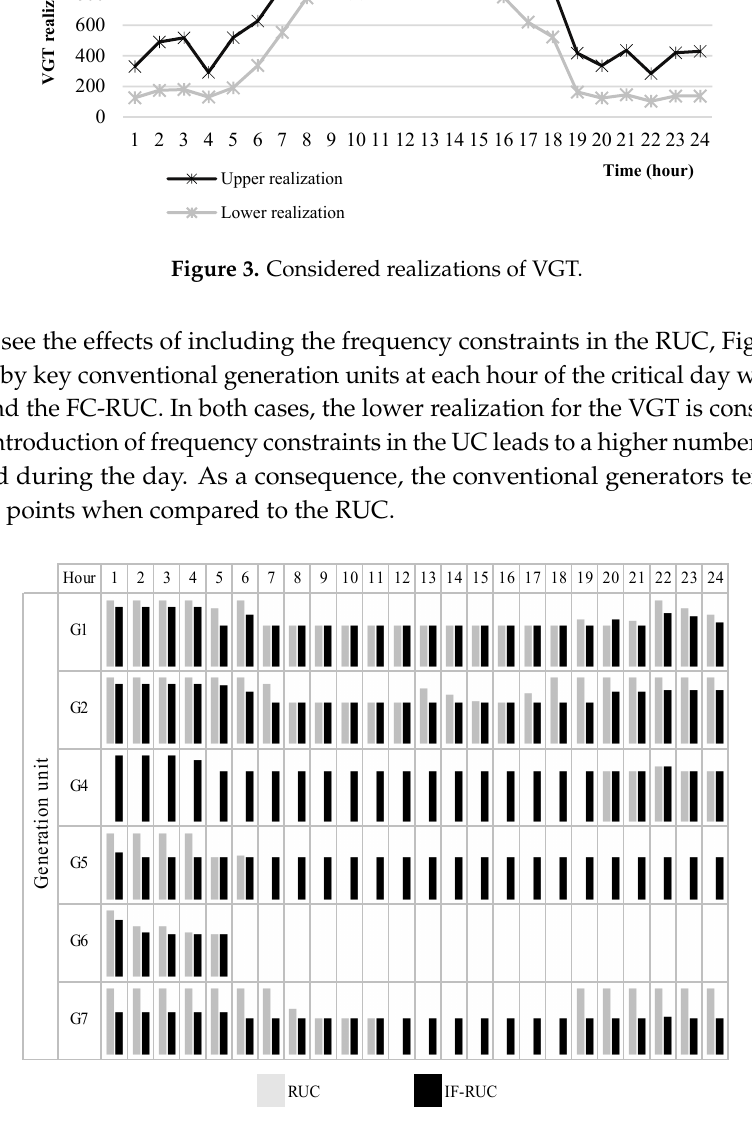
Figure 5. Activation of frequency constraints.